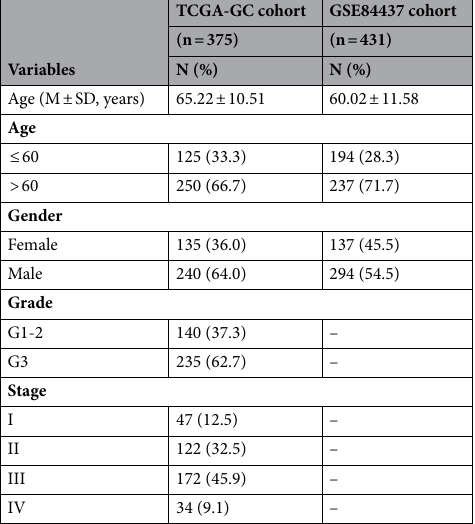
Table 1. Clinicopathologic characteristics of gastric cancer patients in TCGA and GSE84437